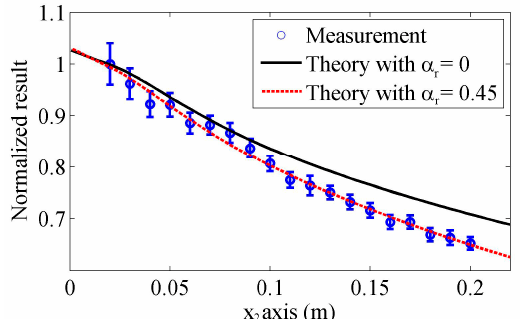
Figure 12. Measured normalized results in the propagation distance and comparisons with the predictions by our proposed model using different attenuation coefficients.